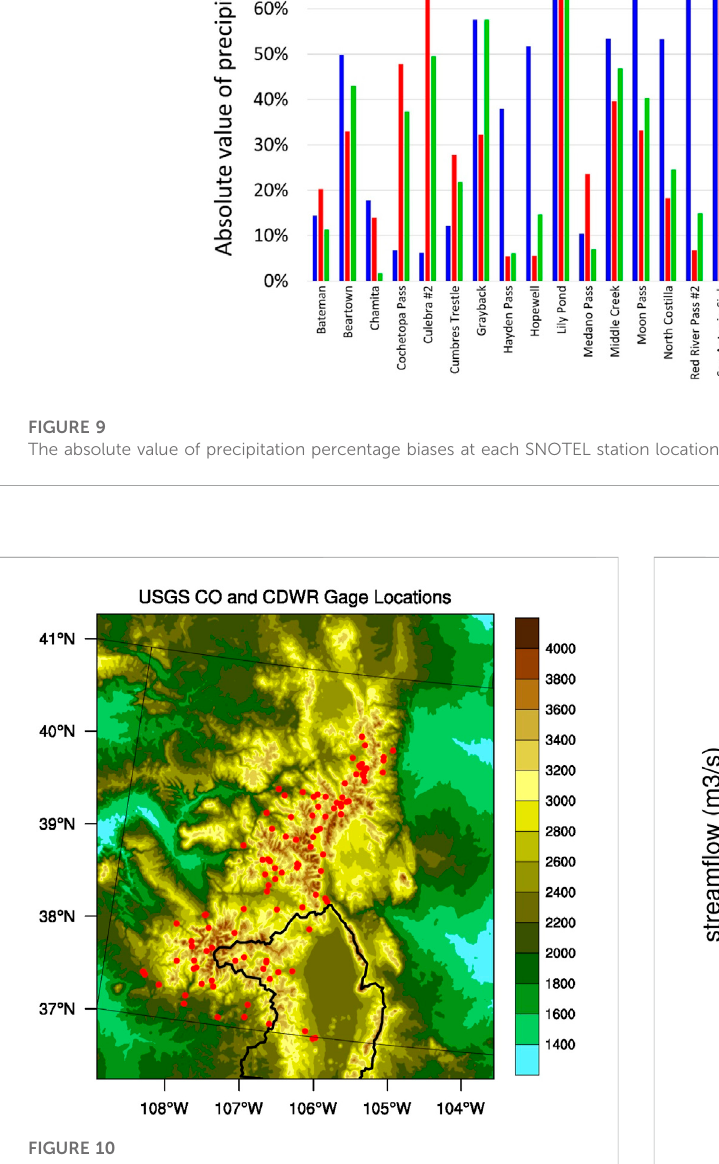
FIGURE 11 Observed and simulated stream fl ow on the Conejos River near Mogote, Colorado for 2021. Its location is marked on Figure